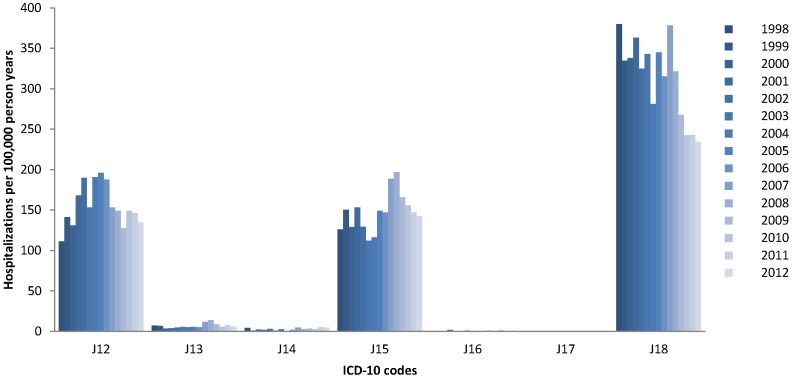
Distribution of ICD-10 code hospitalization rates by calendar year among children <2 years old: J12 (viral pneumonia), J13 (pneumonia due to Streptococcus pneumoniae), J14 (pneumonia due to Haemophilus influenzae), J15 (bacterial pneumonia), J16 (pneumonia due to other infectious organisms), J17 (pneumonia in diseases classified elsewhere), and J18 (pneumonia, unspecified organism).